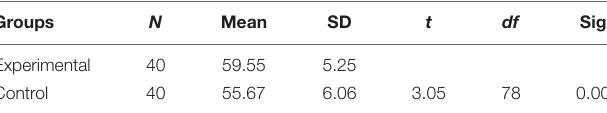
TABLE 5 | Descriptive statistics and t -test results of both groups’ performance on the final exam. Groups N Mean SD df Sig